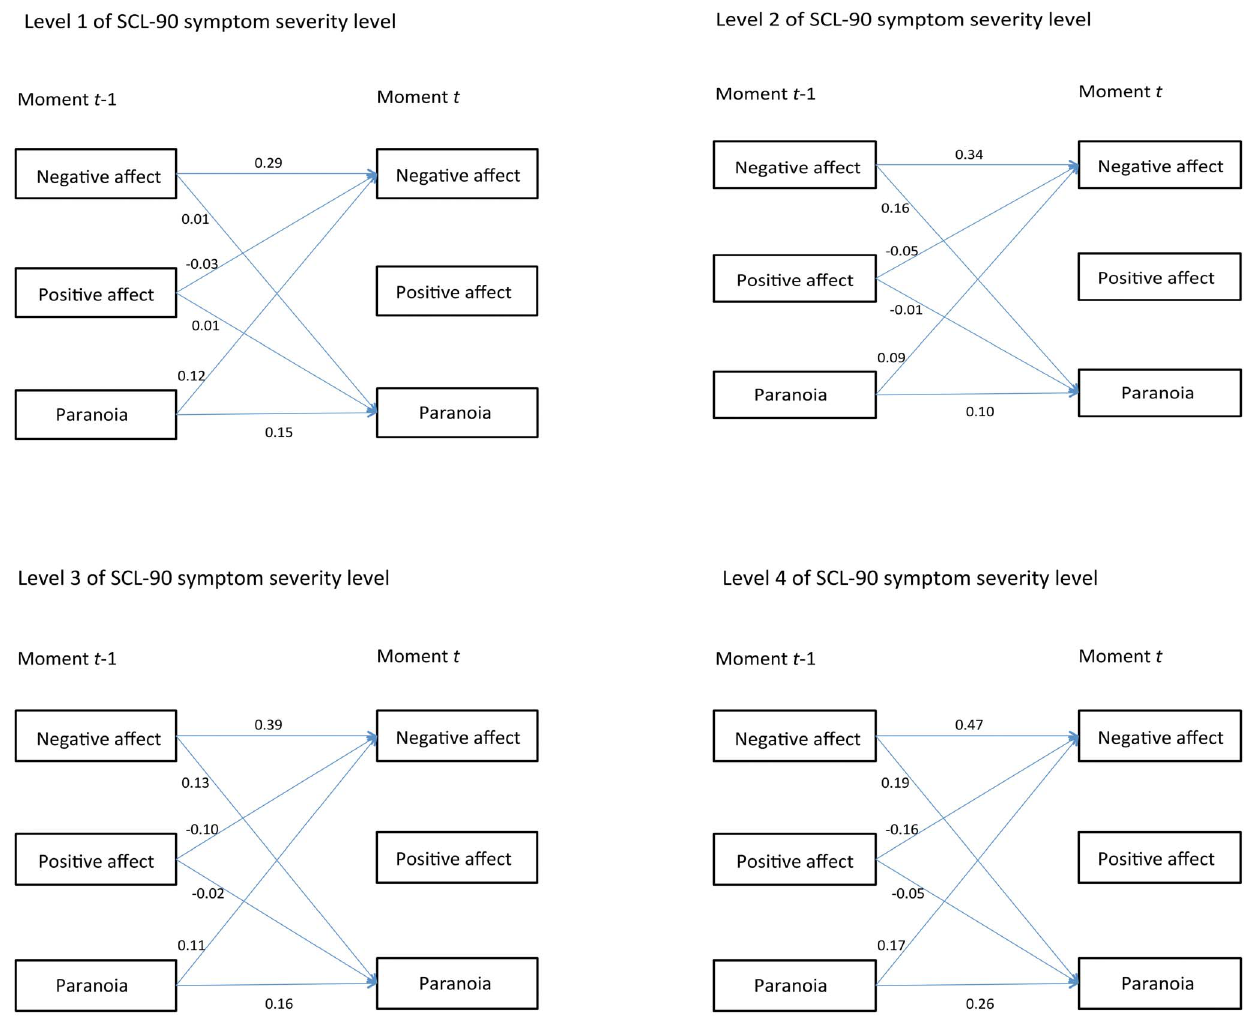
Figure 2. Increasing strength of symptom dynamics with increasing SCL-severity. At the lowest level of SCL-severity (level 1), the regression coefficients of mental states at t -1 predicting mental states at t are weakest. The strength of these regression coefficients increases in a dose-response fashion with increasing SCL-severity and are strongest at the highest SCL-severity level (level 4).